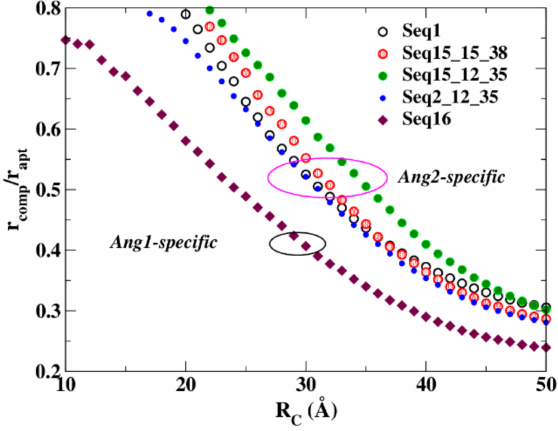
Figure 5. The resistance variation spectra of five different anti-angiopoietin aptamers. Circles identify the Ang-2-specific aptamers; diamonds identify the Ang-1-specific